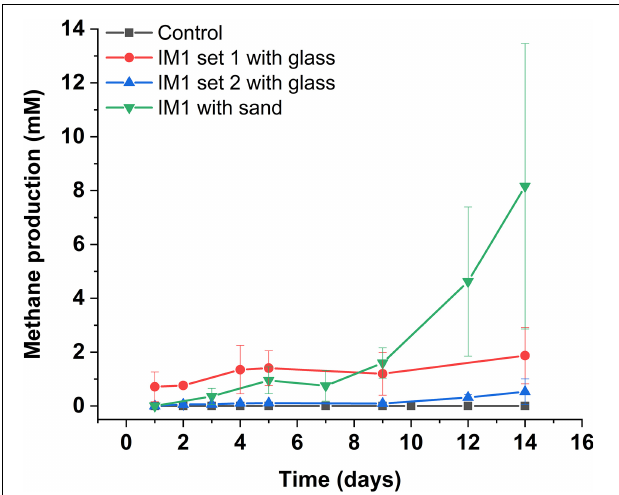
FIGURE 4 | Methane production of Methanobacterium IM1 in flow-through system. Glass-packed Methanobacterium IM1 columns (set 1 and 2) are compared against sand-packed Methanobacterium IM1 column, each data point is the average of three replicates ± SD.